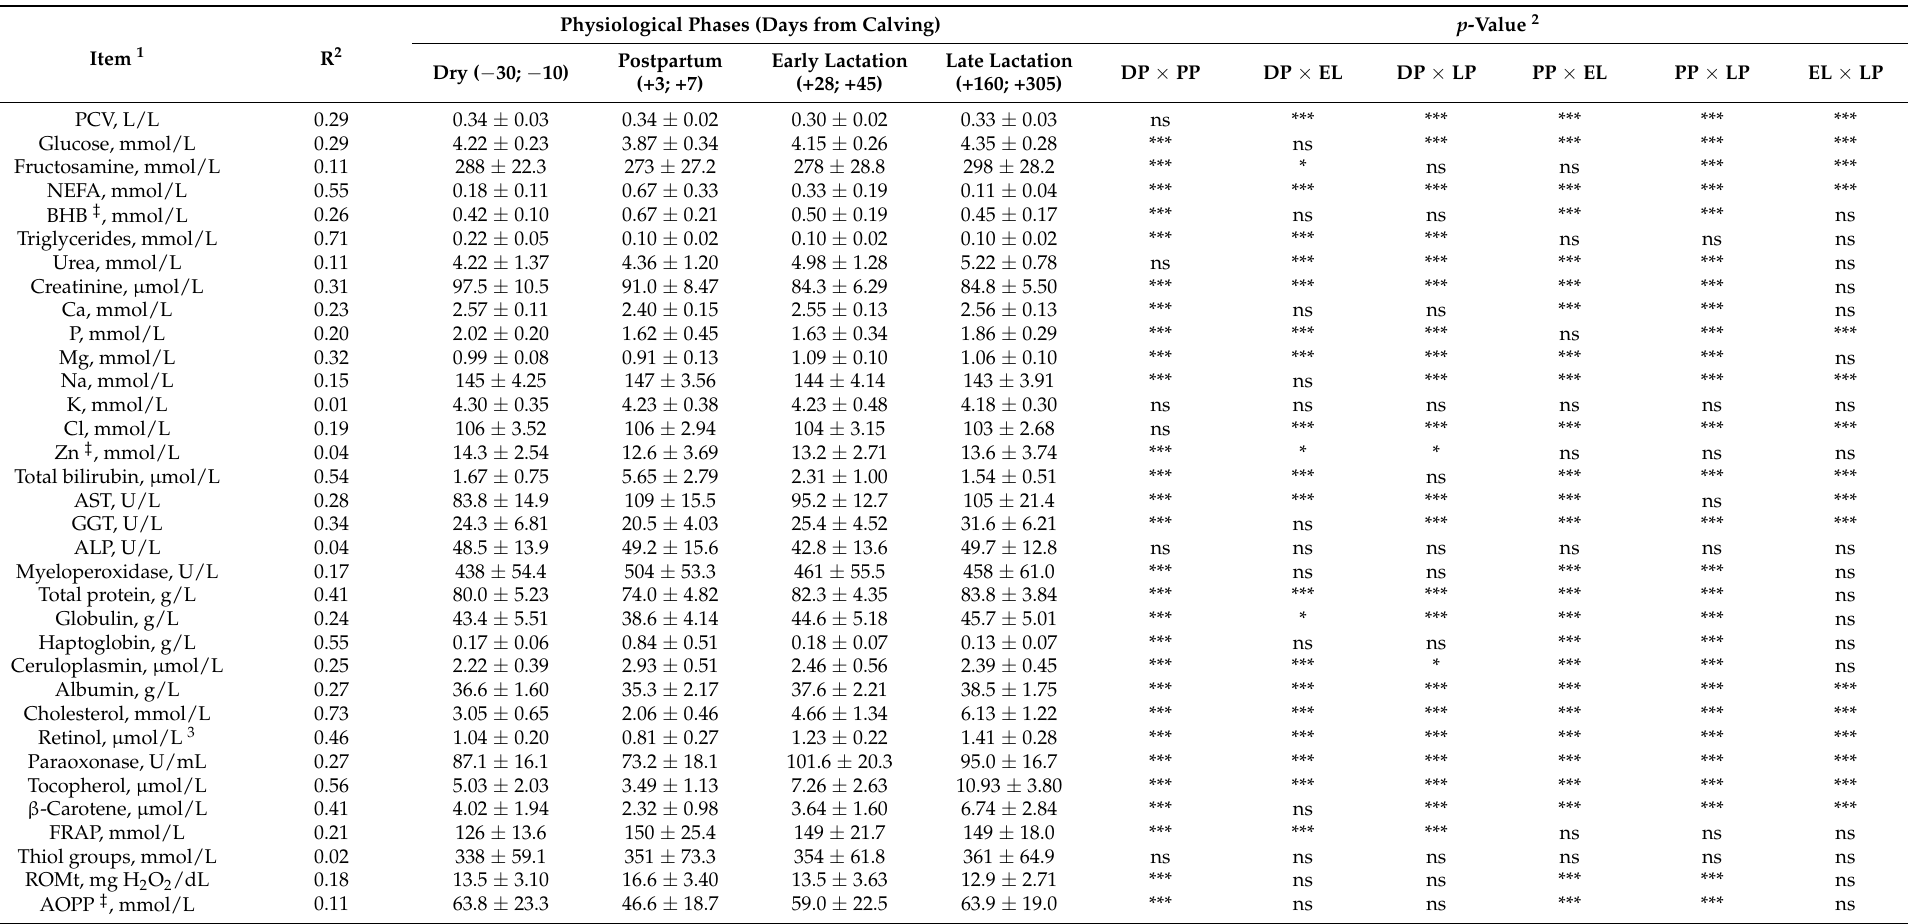
Table 3. Coefficient of determination of the statistical model (R 2 ) and values of plasma analytes (expressed as mean ± standard deviation) assessed in healthy, high welfare raised multiparous Holstein dairy cows during the different stages of the lactation